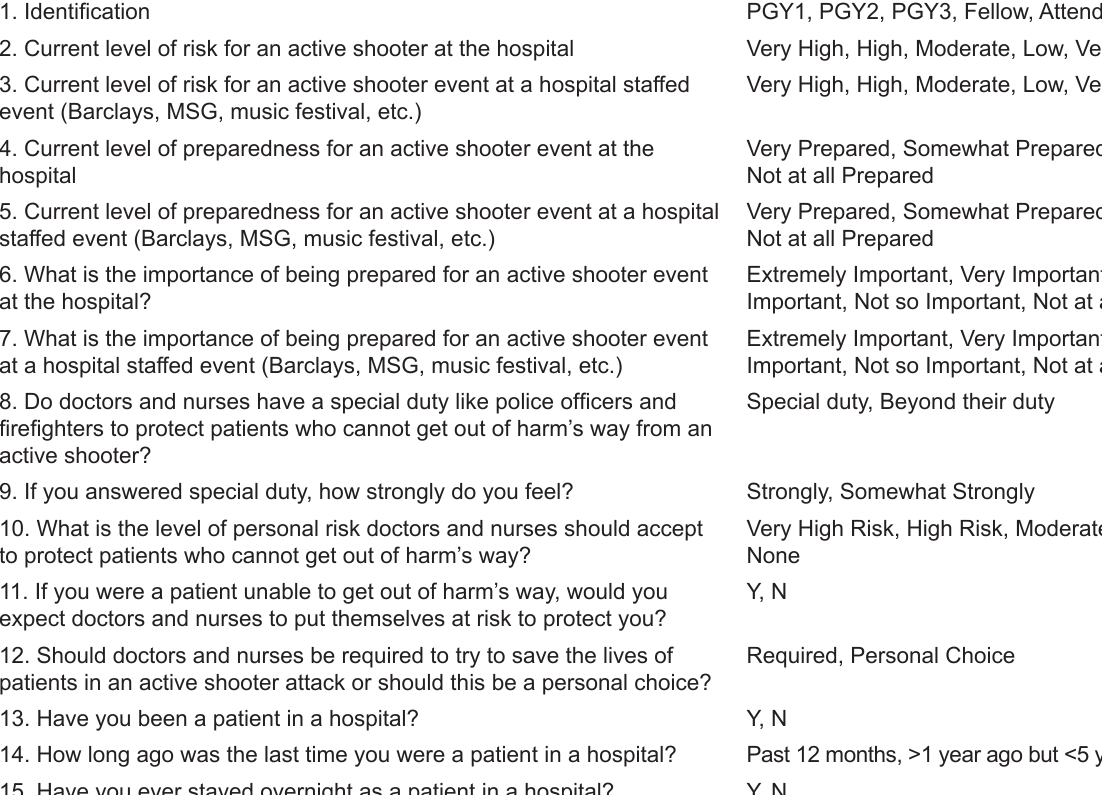
Table 1. Survey questions and response